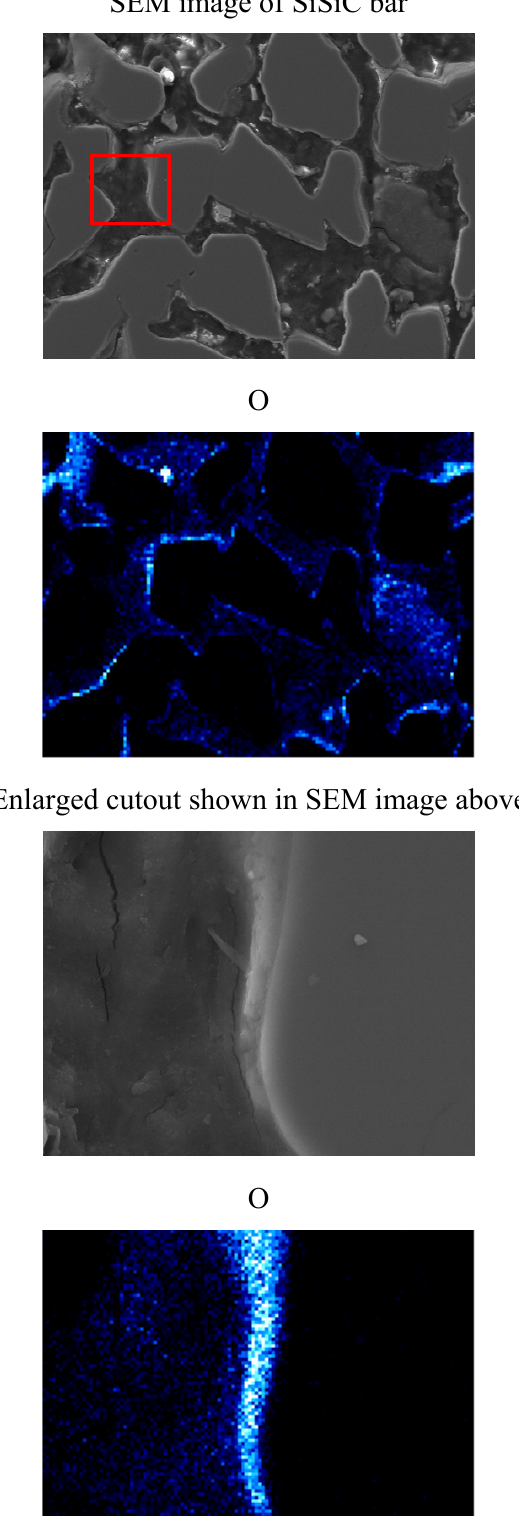
Figure B2. energy dispersive X-ray spectroscopy (EDS) mapping of Monolith 4. SEM image of SiSiC